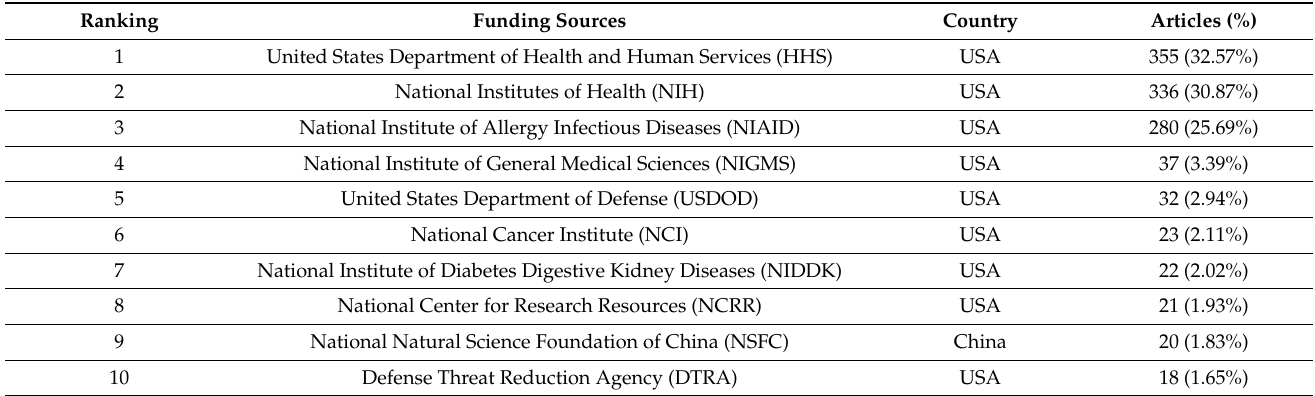
Table 5. Top 10 leading funding sources in anthrax vaccine research between 1991 and